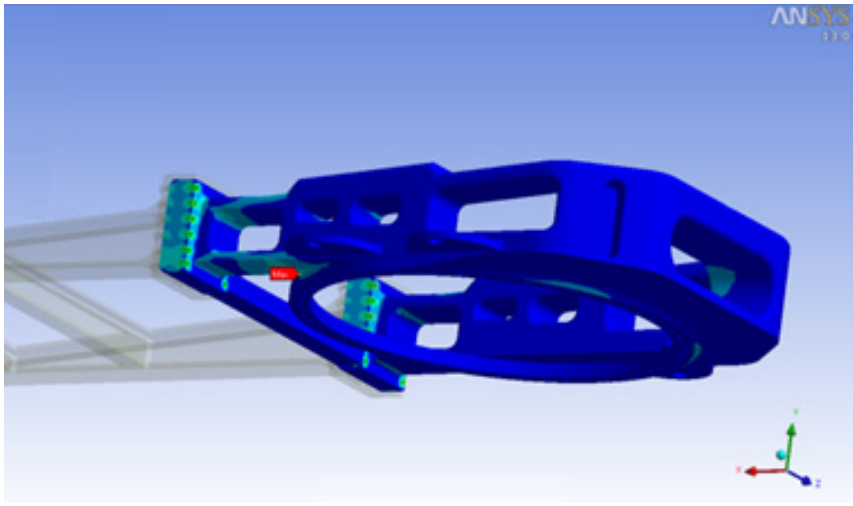
Figure 9. Maximum stress on the cast part [30].